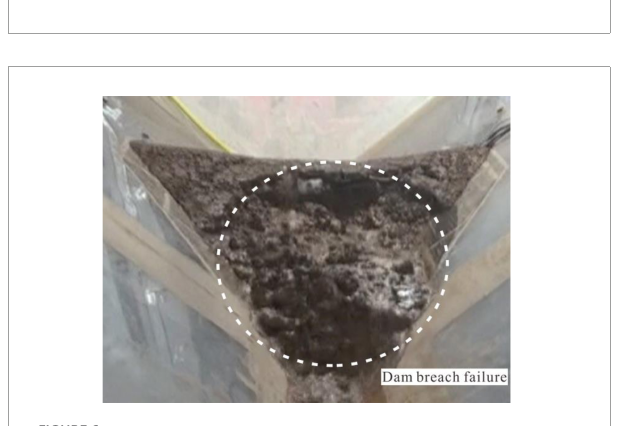
FIGURE6 Dam breach failure.